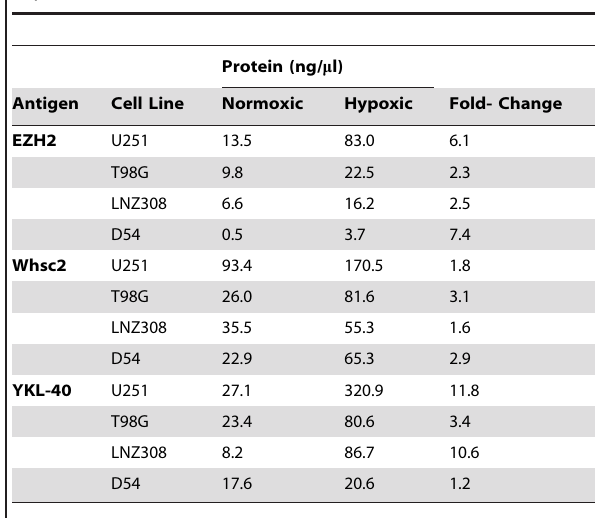
Table 2. Increased production of TAPP induced by hypoxia as determined by a quantitative analysis using the Bio-Rad Experion.